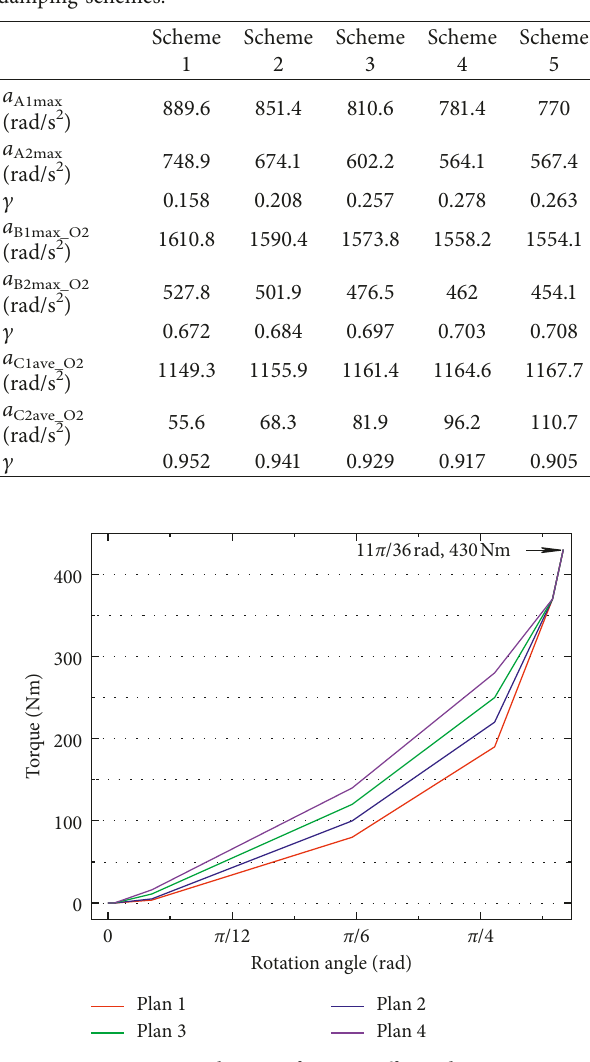
Table 5: DMF vibration control performances under different damping schemes.